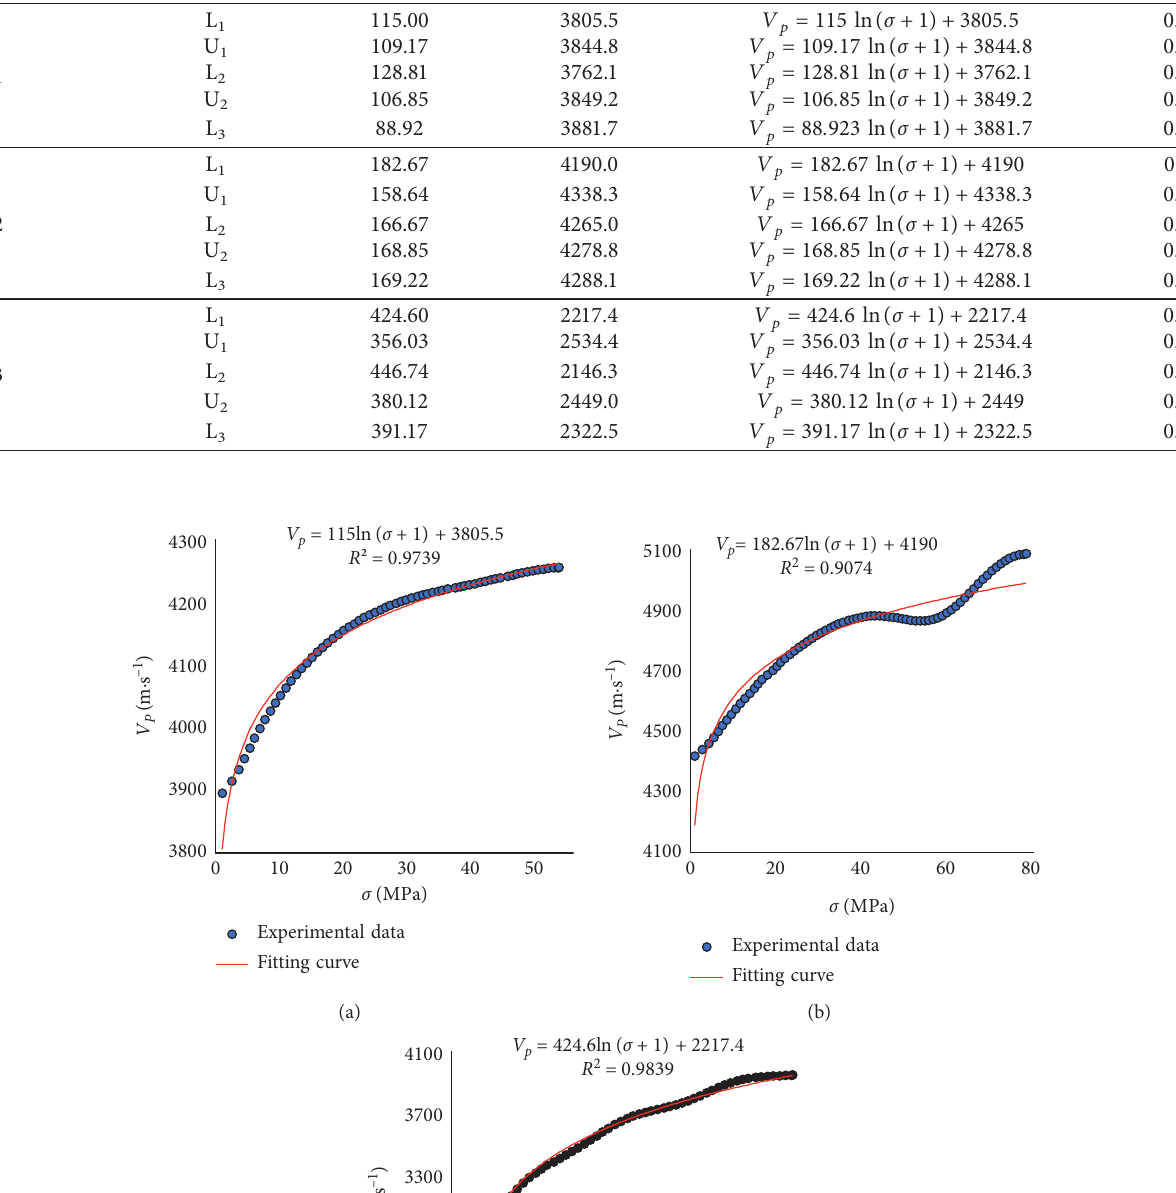
Table 2: Fitting results of the relationship between the P-wave velocity and stress of the sandstone specimens.